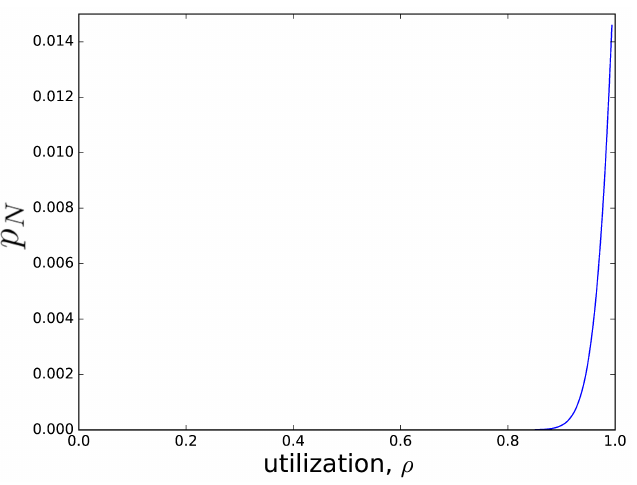
Figure 4. Probability p N of the buffer overflow; illustration of the solution given by Equation